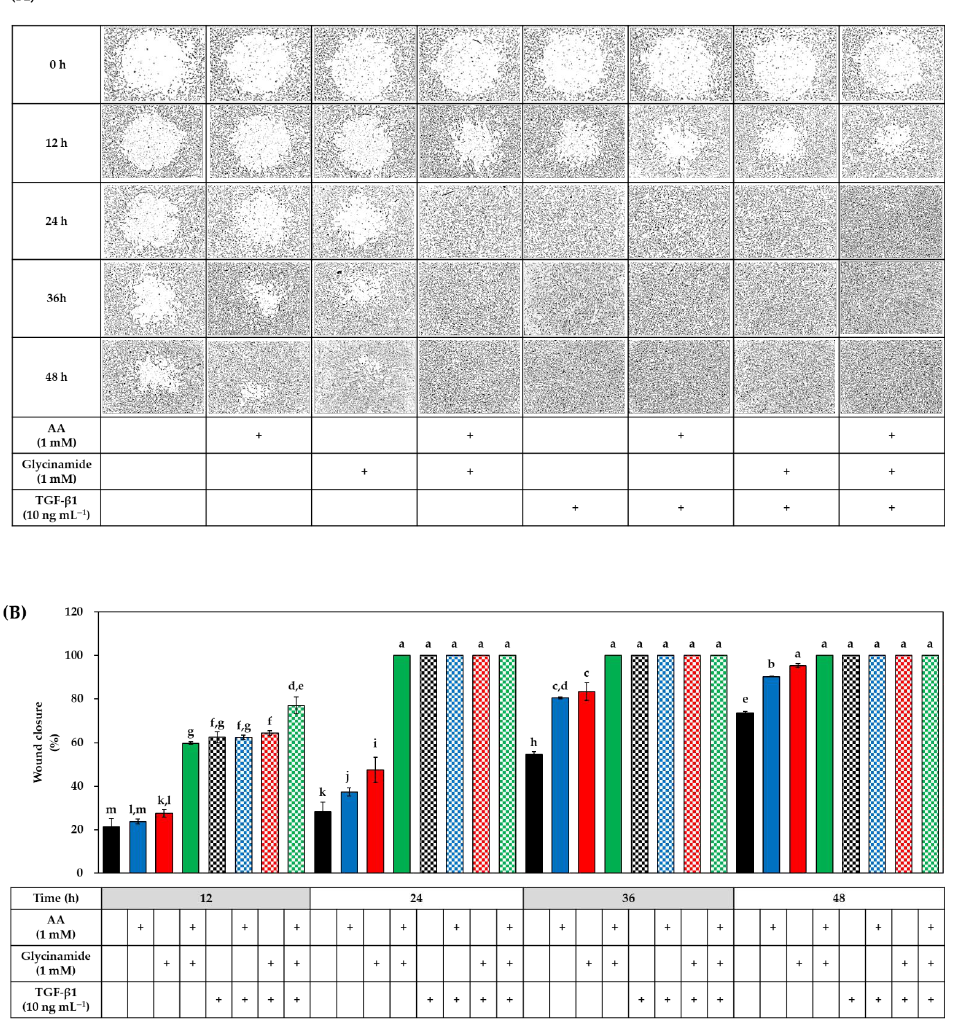
Figure 8. Effects of individual and combined treatments of AA, glycinamide, and TGF- β1 on the wound closure in HDFs. Cells were cultured for 12 h in the presence of a stopper to create a small circular wound. After removing the stopper, cells were treated with AA, glycinamide, or TGF- β1 each or in combinations for 48 h. Representative microscopic wound images before and after treatments are shown in panel ( A ). Quantitated data for wound closure (%) at different time points are shown in panel ( B ) (means ± SD, n = 3). Groups that share the same alphabet letters (a – m) do not have significantly different means at the p < 0.05 level.